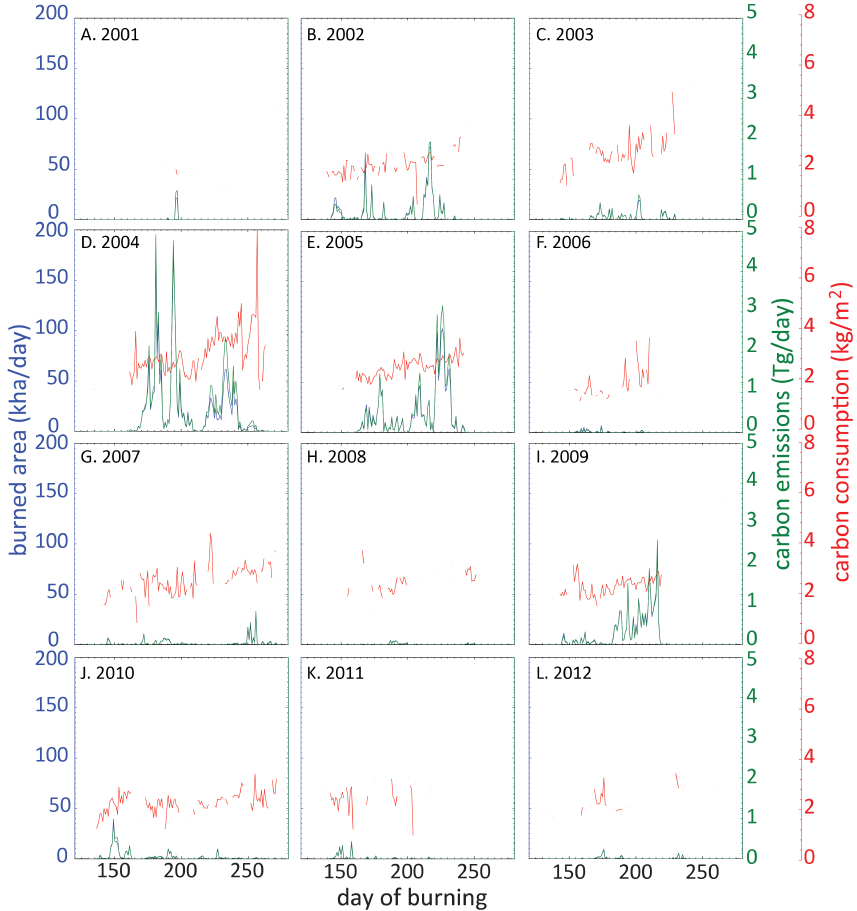
Figure 6. Daily burned area, carbon consumption and emissions derived from the Alaskan Fire Emissions Database for the years 2001–2012. Table 2. Annual burned area, carbon emissions, and mean carbon consumption between 2001 and 2010 from the Alaskan Fire Emis- sions Database (AKFED), the Wildland Fire Emissions Information System (WFEIS), and the Global Fire Emissions Database version 3s (GFED3s). Values were extracted for the domain between 58 and 71.5 ◦ N, and 141 and 168 ◦ W. We used the MCD64A1 burned area product and the default parameters within the WFEIS emissions calculator (http://wfeis.mtri.org/calculator, last access: 14 May 2015). We included both emissions from natural and agricultural